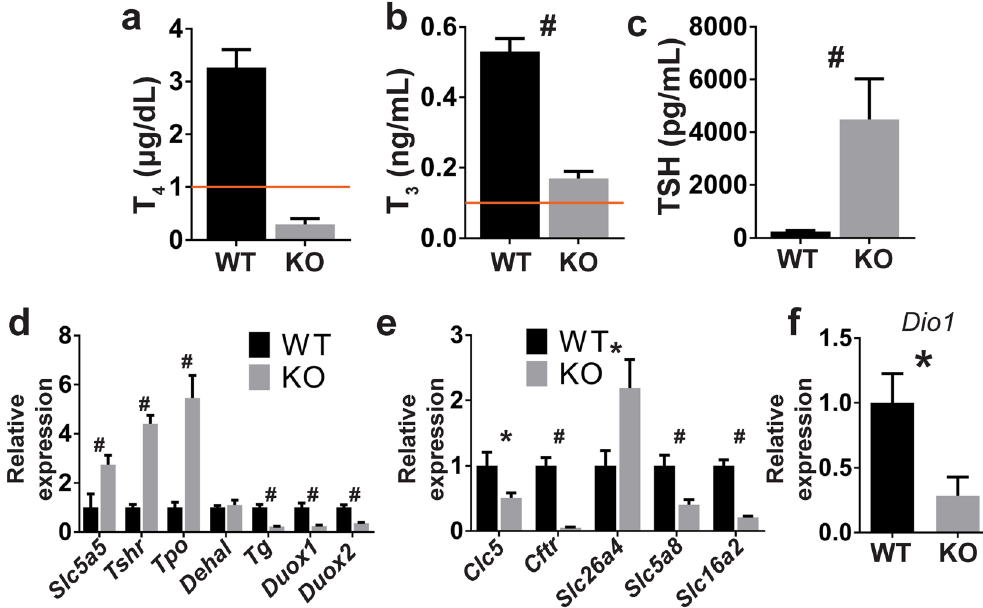
Figure 4. Reduced I − intake impairs TH biosynthesis in NIS KO mice. ( a , b ) Serum T 4 and T 3 levels of male WT and NIS KO mice fed a MID. The horizontal line indicates the detection limit of the T 4 and T 3 ELISA kits. ( c ) Serum TSH levels of male WT and NIS KO mice fed a MID (n = 5). ( d ) Thyroid mRNA expression levels of genes involved in TH biosynthesis (n = 7–8). ( e ) Thyroid mRNA expression levels of apical thyroid proteins. Each group contained 4–5 males and 3 females fed a MID. No sex differences were observed. ( f ) Liver Dio1 mRNA expression levels in males (n = 7–8). Slc5a5 encodes NIS, Tshr = thyroid stimulating hormone receptor, Tpo = thyroid peroxidase, Dehal = iodotyrosine deiodinase, Tg = thyroglobulin, Duox 1 and 2 = Dual oxidase 1 and 2, Clc5 = chloride voltage-gated channel 5, Cftr = cystic fibrosis transmembrane conductance regulator, Slc26a4 encodes pendrin, Slc5a8 encodes SMCT, Slc16a2 = solute carrier family 16 member 2, and Dio1 = iodothyronine deiodinase 1. * Indicates p < 0.05, # p <